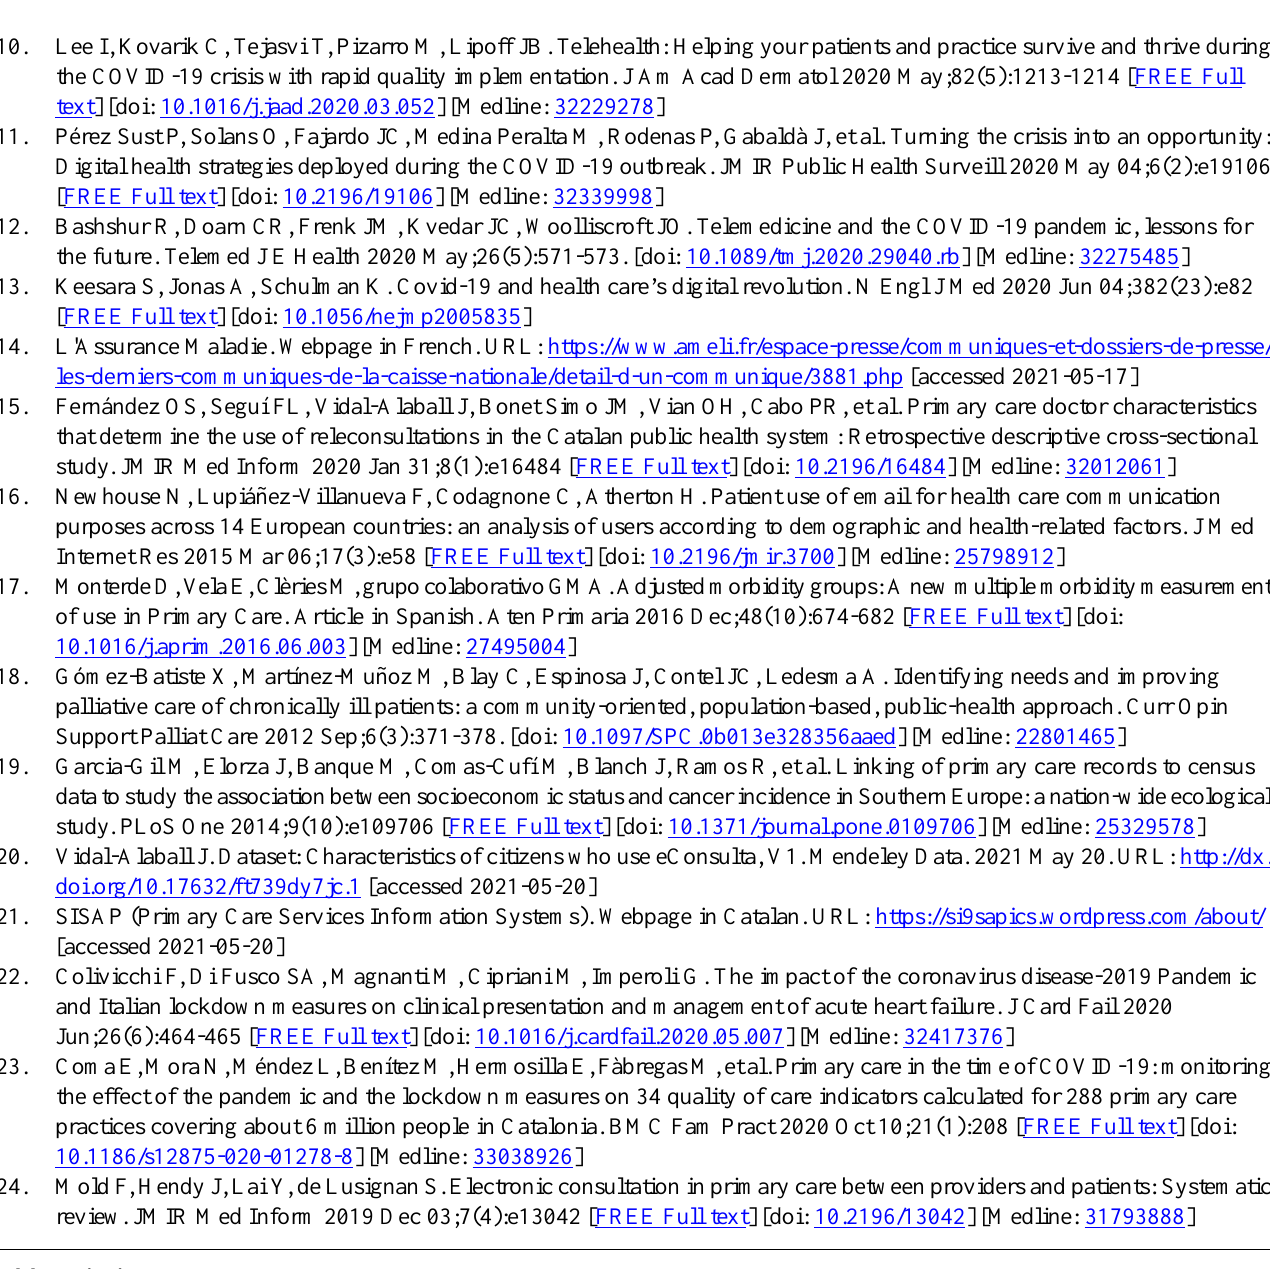
Abbreviations ANOVA: analysis of variance ICS: Catalan Health Institute GMA: adjusted morbidity group MACA: patients with advanced chronic diseases MEDEA: Mortality in small Spanish areas and Socioeconomic and Environmental Inequalities PCC: patients with complex chronic